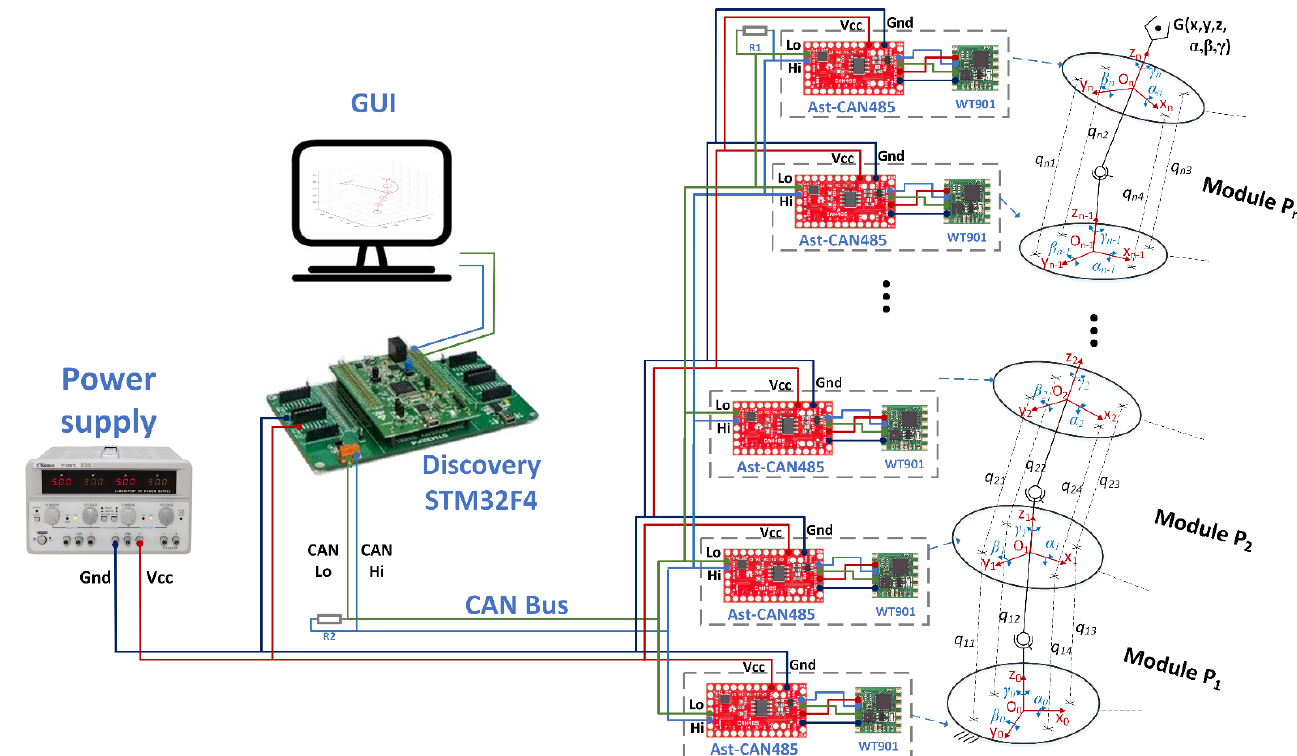
Figure 3. Schematic of the shape sensing computational